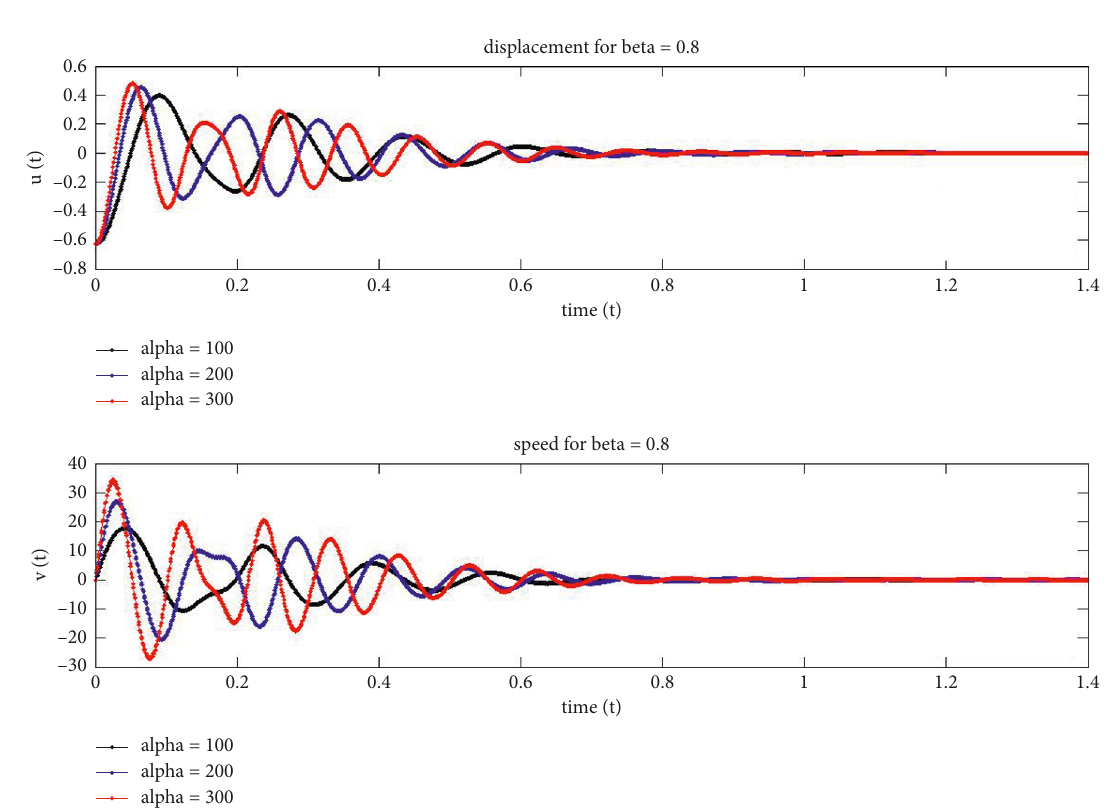
Figure 2: Influence of the parameter α on the beam vibrations in x � 0 ,